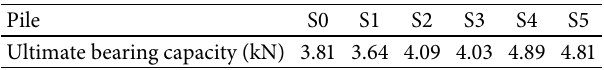
Figure 14: Settlement of simulation piles with different length-diameter ratios (unit: m). (a) S1. (b) S3. (c) S5. Table 7: The ultimate bearing capacity of simulation